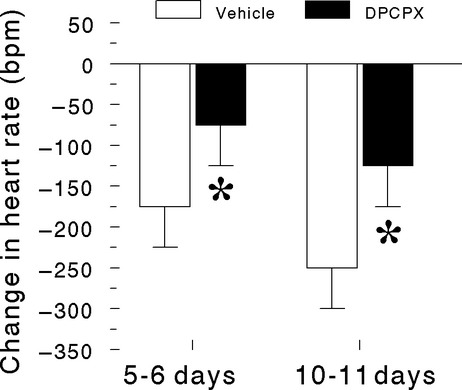
Influence of postnatal age and DPCPX on the change in heart rate from control during hypoxia-induced primary apnea in rat pups. Data are means ± 1 SD; n = 9 for vehicle and DPCPX in 5- to 6-day-old pups and n = 8 for vehicle and DPCPX 10- to 11-day-old pups. *P < 0.05 vehicle versus DPCPX at a given postnatal age by analysis of variance (ANOVA) followed by a Holm-Sidak multiple comparison test ANOVA. bpm, beats per minute.